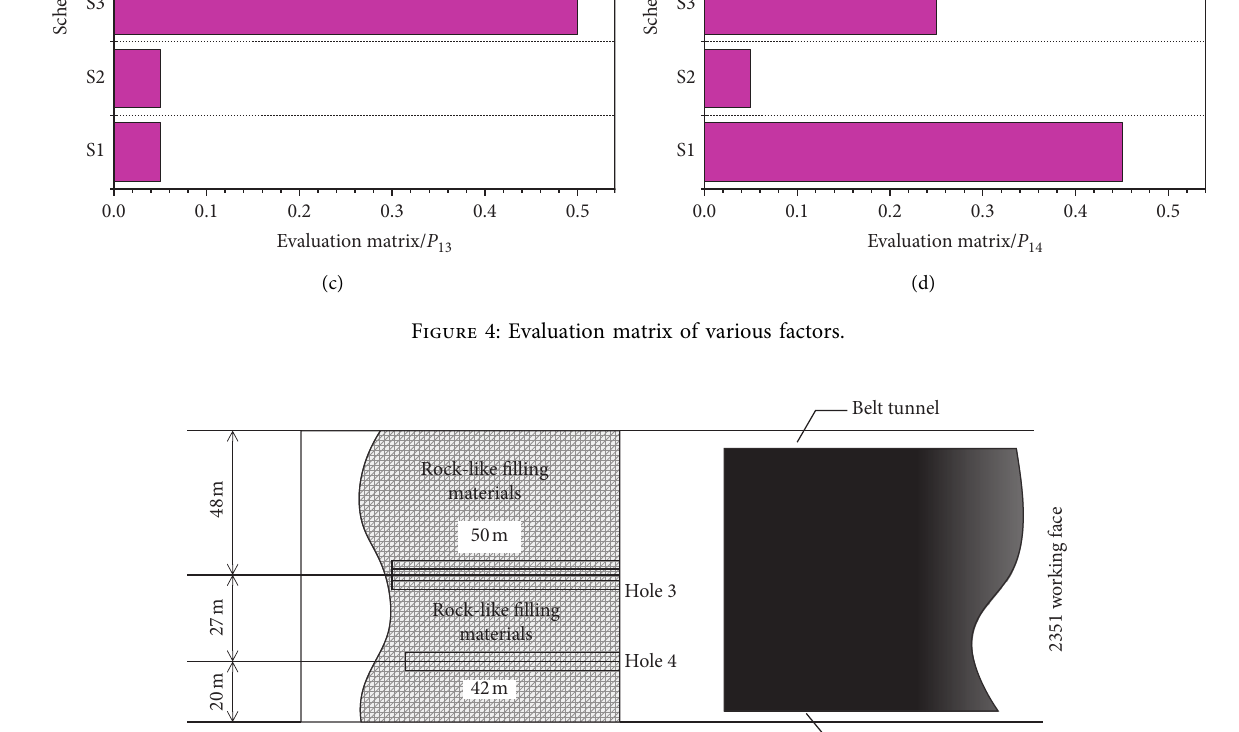
Figure 5: Arrangement scheme of drill hole